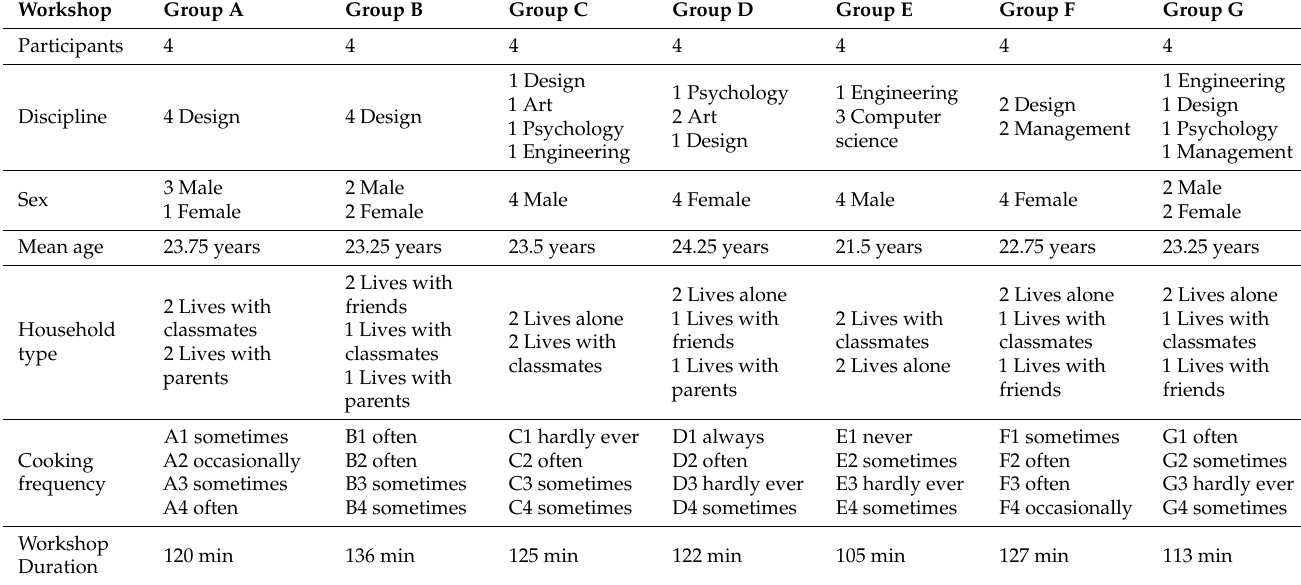
Table 1. Workshop and participant